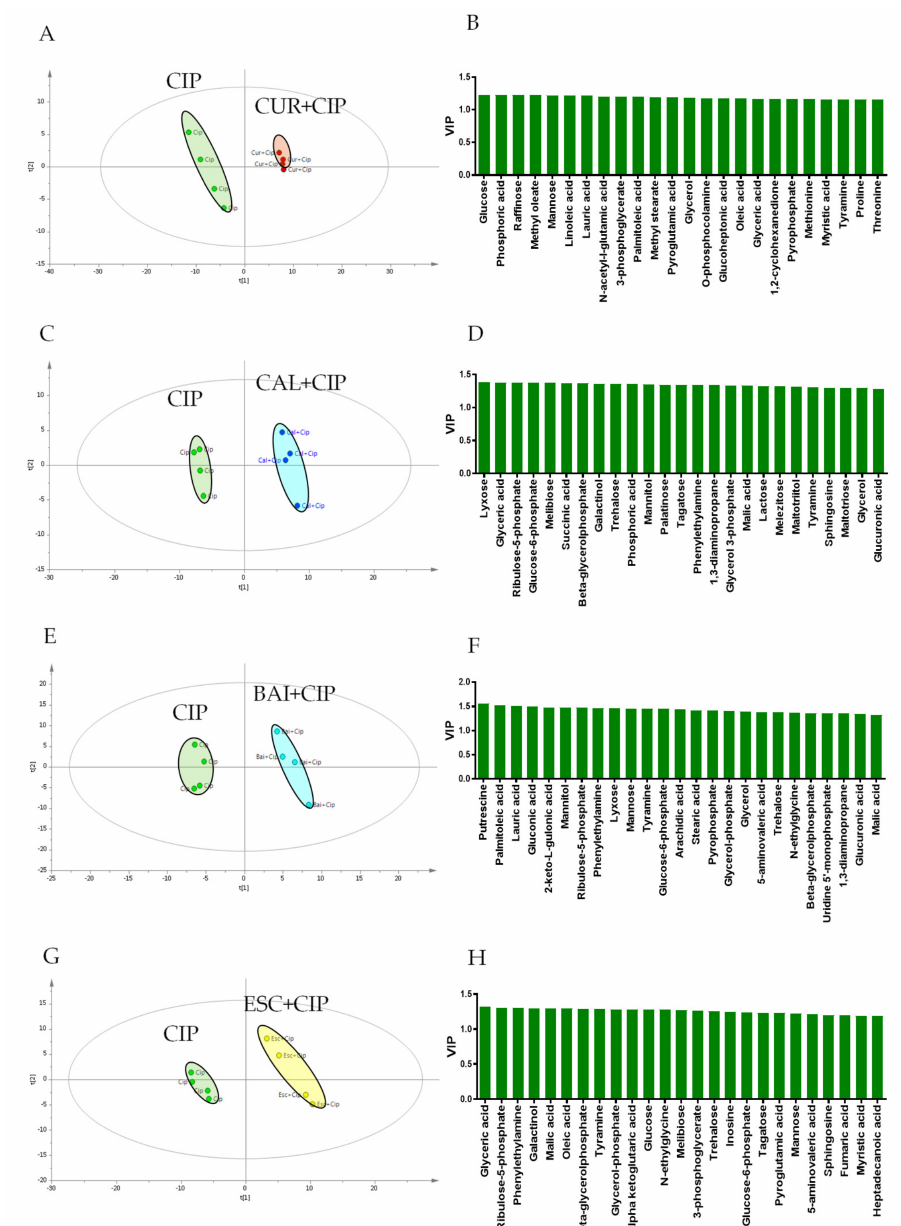
Figure 4. Partial Least-Squares Discriminant Analysis score chart and Variable importance charts obtained after the comparison of biofilm cells treated with ciprofloxacin alone with those treated with combinations of curcumin, cinnamaldehyde, baicalein, and esculetin hydrate. ( A ) PLS-DA score plot shows a clear separation between P. aeruginosa cells treated with ciprofloxacin alone and in combination with curcumin. The R2 and Q2 values for the biofilm samples were 0.999 and 0.983, respectively. ( C ) PLS-DA score plot shows a clear separation between P. aeruginosa cells treated with ciprofloxacin alone and in combination with cinnamaldehyde. The R2 and Q2 values for the biofilm samples were 0.998 and 0.971, respectively; ( E ) PLS-DA score plot shows a clear separation between P. aeruginosa cells treated with ciprofloxacin alone and in combination with baicalein. The R2 and Q2 values for the biofilm samples were 0.995 and 0.960, respectively. ( G ) PLS-DA score plot shows a clear separation between P. aeruginosa cells treated with ciprofloxacin alone and in combination with esculetin hydrate. The R2 and Q2 values for the biofilm samples were 0.998 and 0.990, respectively. ( B , D , F , H ) VIP charts of metabolites that are effective in separating the